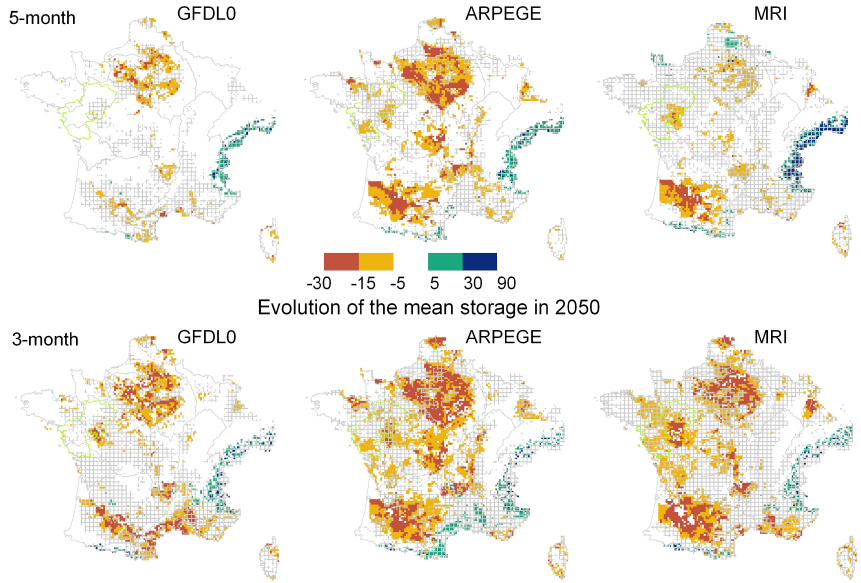
Figure 15. Evolution of the mean maximum storage of small farm dams in 2050 as projected using three downscaled climate projections for the two filling periods. Results that are not significant at the 95% level are hatched.